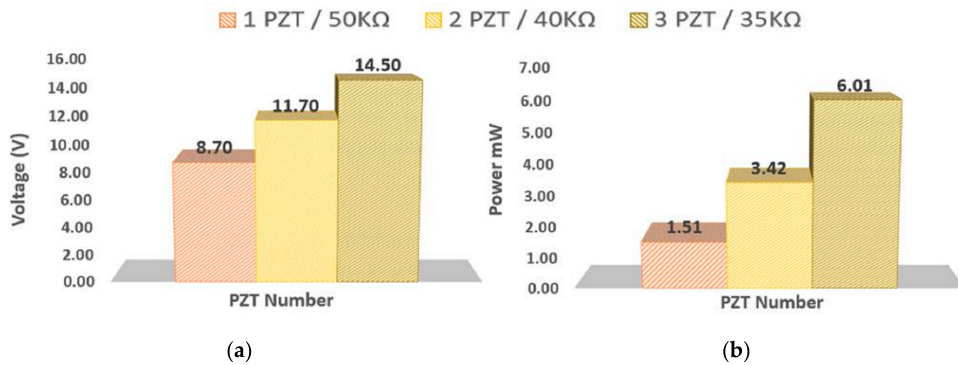
Figure 18. Effect of the piezoelectric cantilever number on ( a ) output voltage and ( b ) output power. Figure 18. E ff ect of the piezoelectric cantilever numbers on ( a ) output voltage and ( b ) output power.